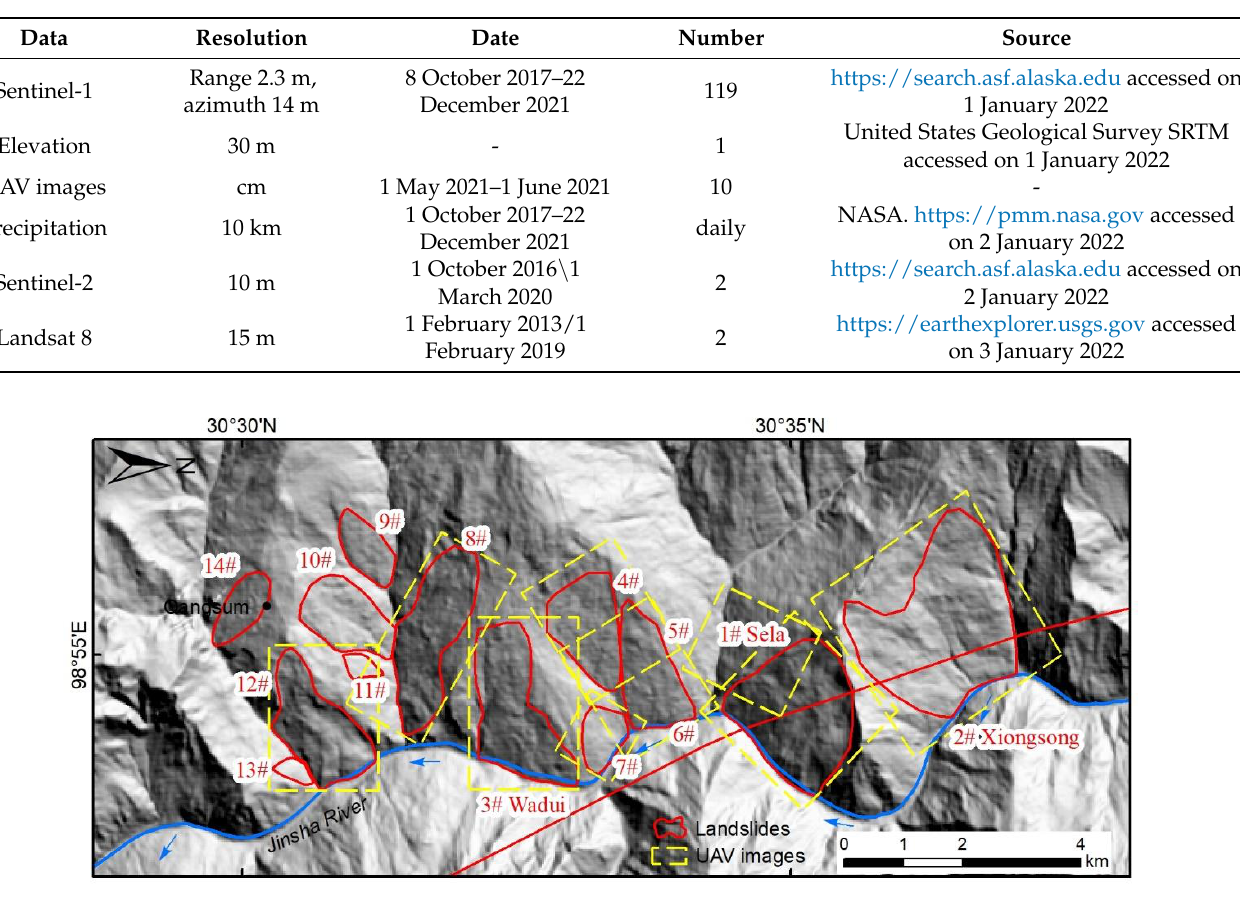
Table 1. Datasets used in this study.